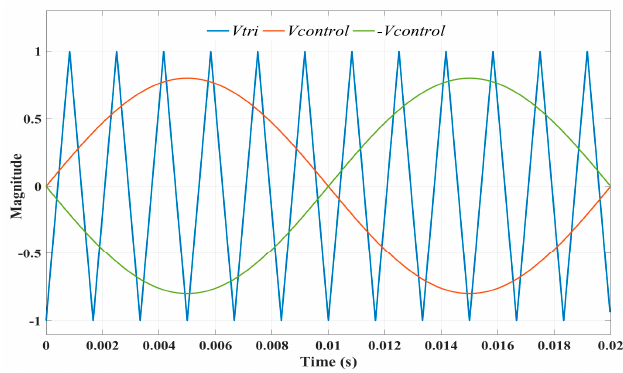
Figure 4. Sinusoidal pulse-with modulation (PWM) for unipolar voltage switching.